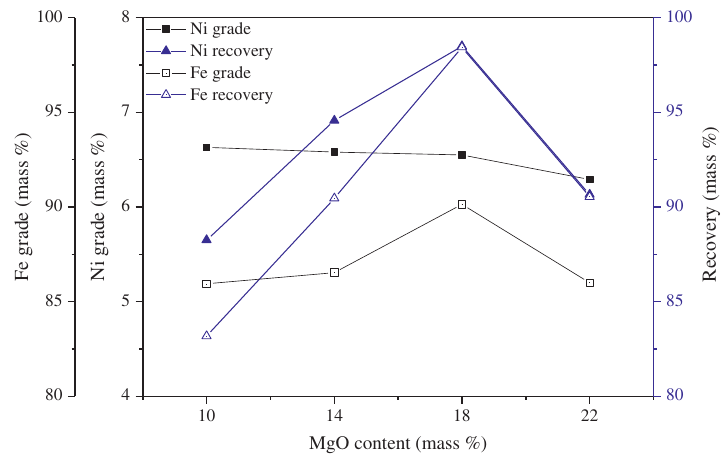
Figure 6: Effects of MgO content on Fe and Ni grade and recovery of ferronickel (Smelting at 1,550°C for 10 min, with coke ratio of 10%, binary basicity of slag as 1.0, 3% of Al 2 O 3 in slag).